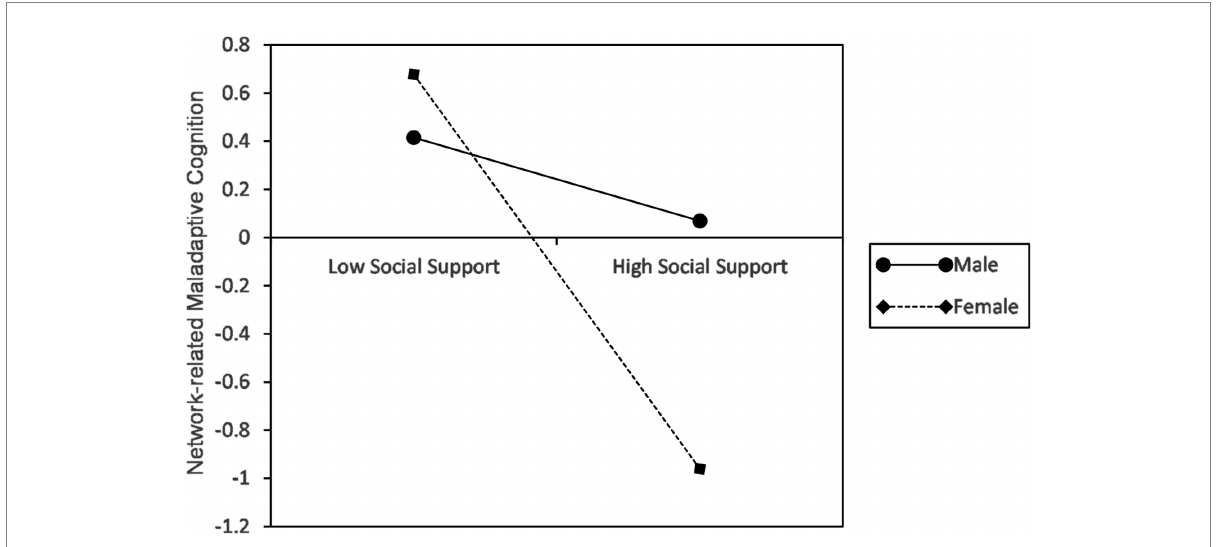
FIGURE 3 Moderating effect of gender on social support and network-related maladaptive